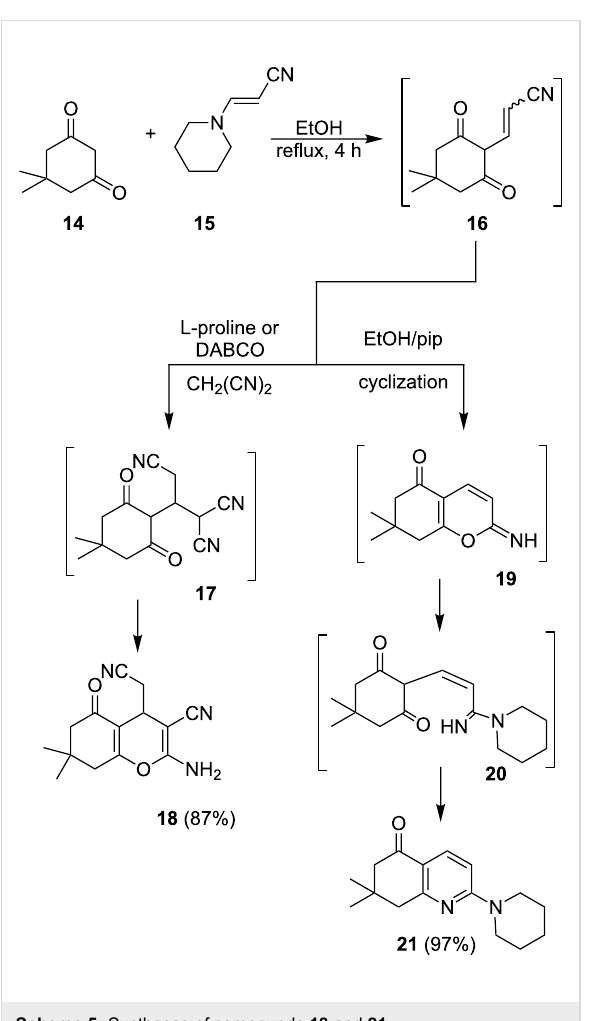
conducted in the absence of malononitrile, dihydroquinolinone 21 is generated through a pathway involving the intermediate imines 19 and 20 (Scheme 5). The structure of 21 was deter- mined by X-ray crystallographic methods (Figure 4).